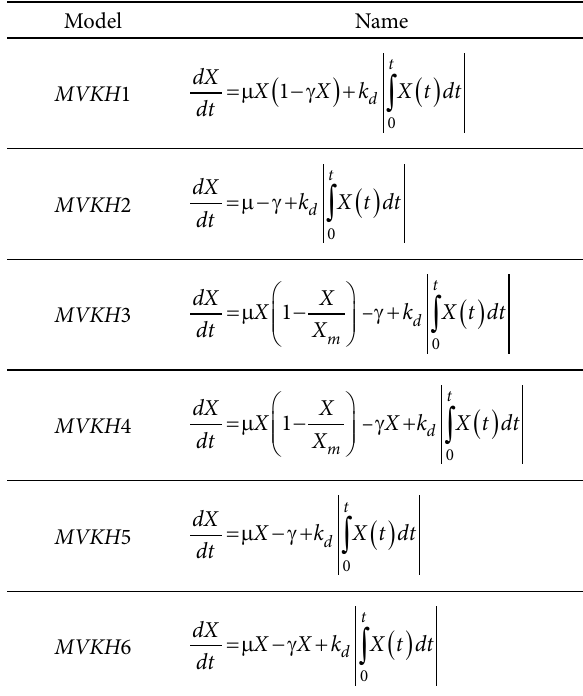
Table 1. The microbial growth kinetic models proposed